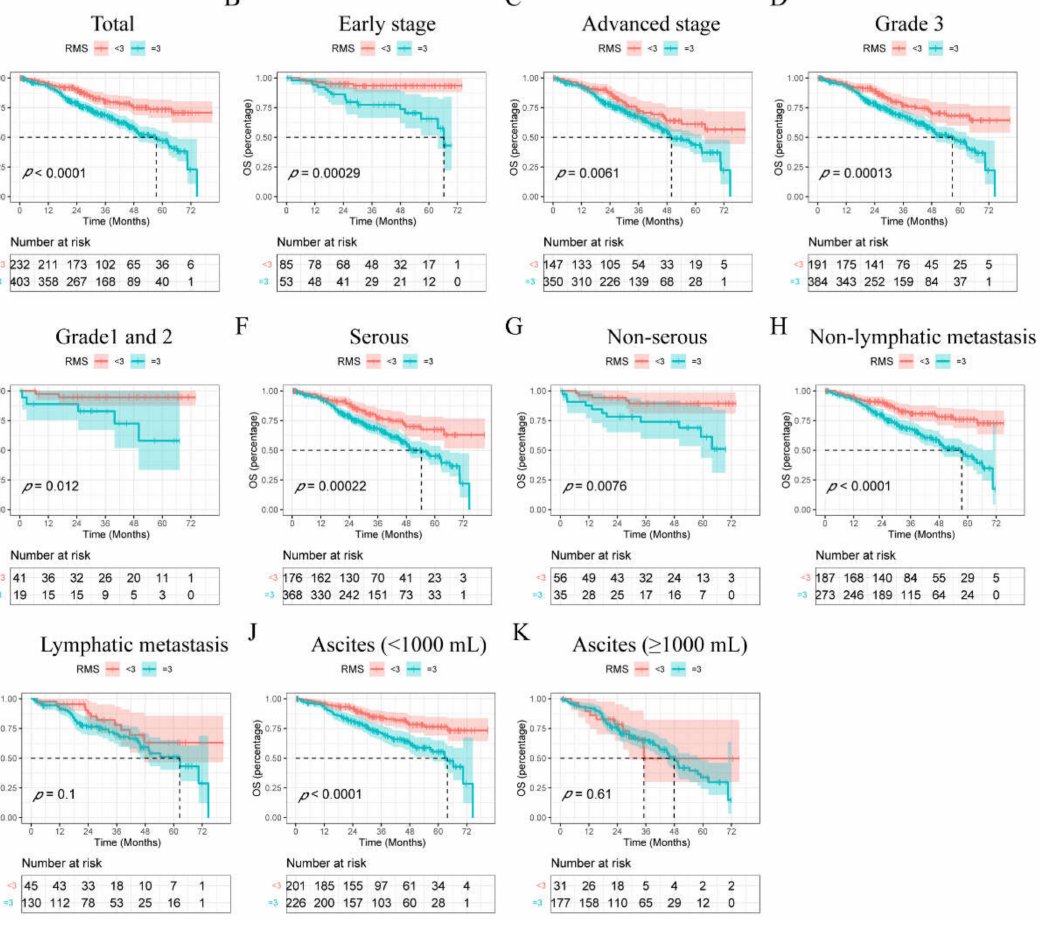
Figure 2. Kaplan–Meier analyses of OS in patients who underwent curative surgery for EOC. ( A ), Association of RMS preoperatively with OS in all patients who underwent curative surgery for EOC. ( B , C ) In patients with different FIGO stages. ( D , E ) In patients with different pathologic grades. ( F , G ) In patients with different histologic types. ( H , I ) In patients with different volumes of ascites. ( J , K ) In patients with different statuses of lymphatic